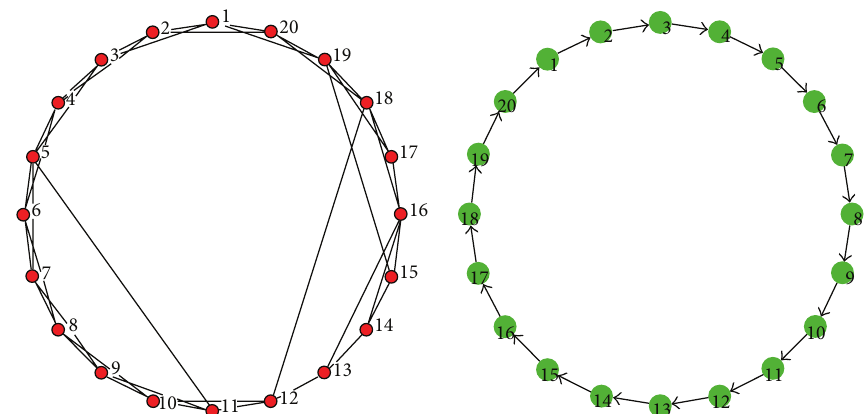
Figure 1: A 20-node network generated using the WS small-world algorithm, where the rewiring probability 𝑝 = 0.1 (left); a 20-node directed ring network (right).